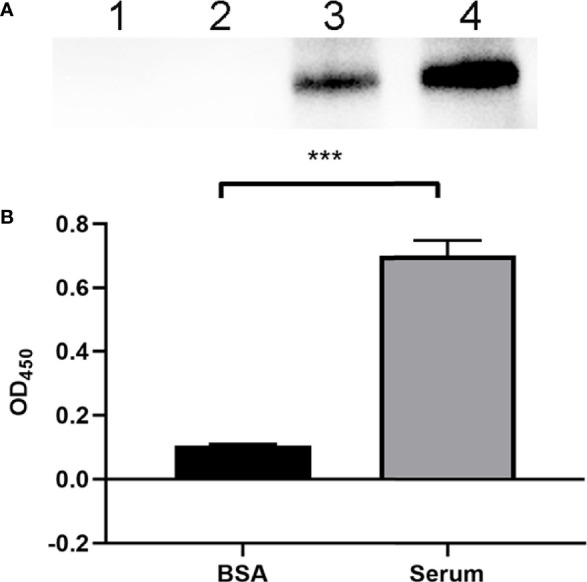
Identification of the FH-binding ability of ExPEC. (A) Western blotting to detect the ability of ExPEC to bind FH. ExPEC strain RS218 was incubated with 10% human serum or BSA. The bacteria, the last washing buffer, and human serum were analyzed by Western blotting. Lane 1, the bacteria after incubated with BSA (negative control); lane 2, the last washing buffer; lane 3, the bacteria after incubated with human serum; and lane 4, the human serum. (B) Whole-bacteria ELISA assay to detect the binding of FH after ExPEC incubated with human serum. ExPEC incubated with BSA acted as the negative control. Data are expressed as the mean ± SEM of three independent experiments. Statistical analysis was performed using the unpaired t test (***p < 0.001).